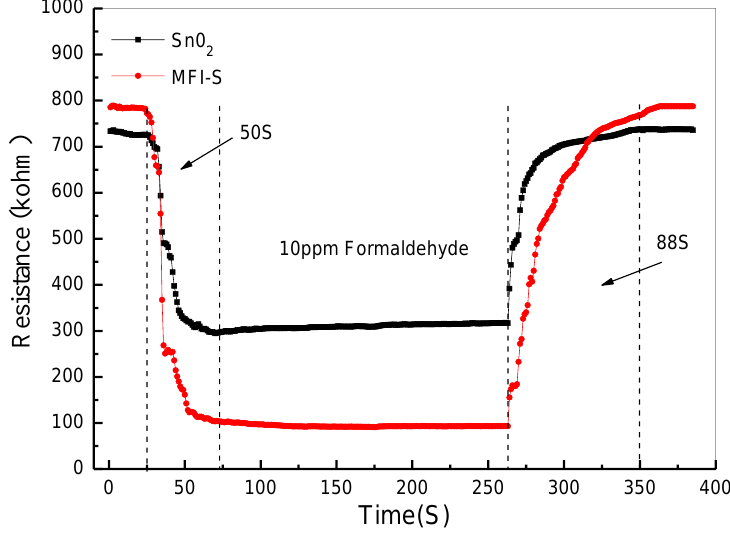
Figure 9. Transient response and recovery properties of SnO 2 and MFI-S coated SnO 2 sensors to 10 ppm formaldehyde.